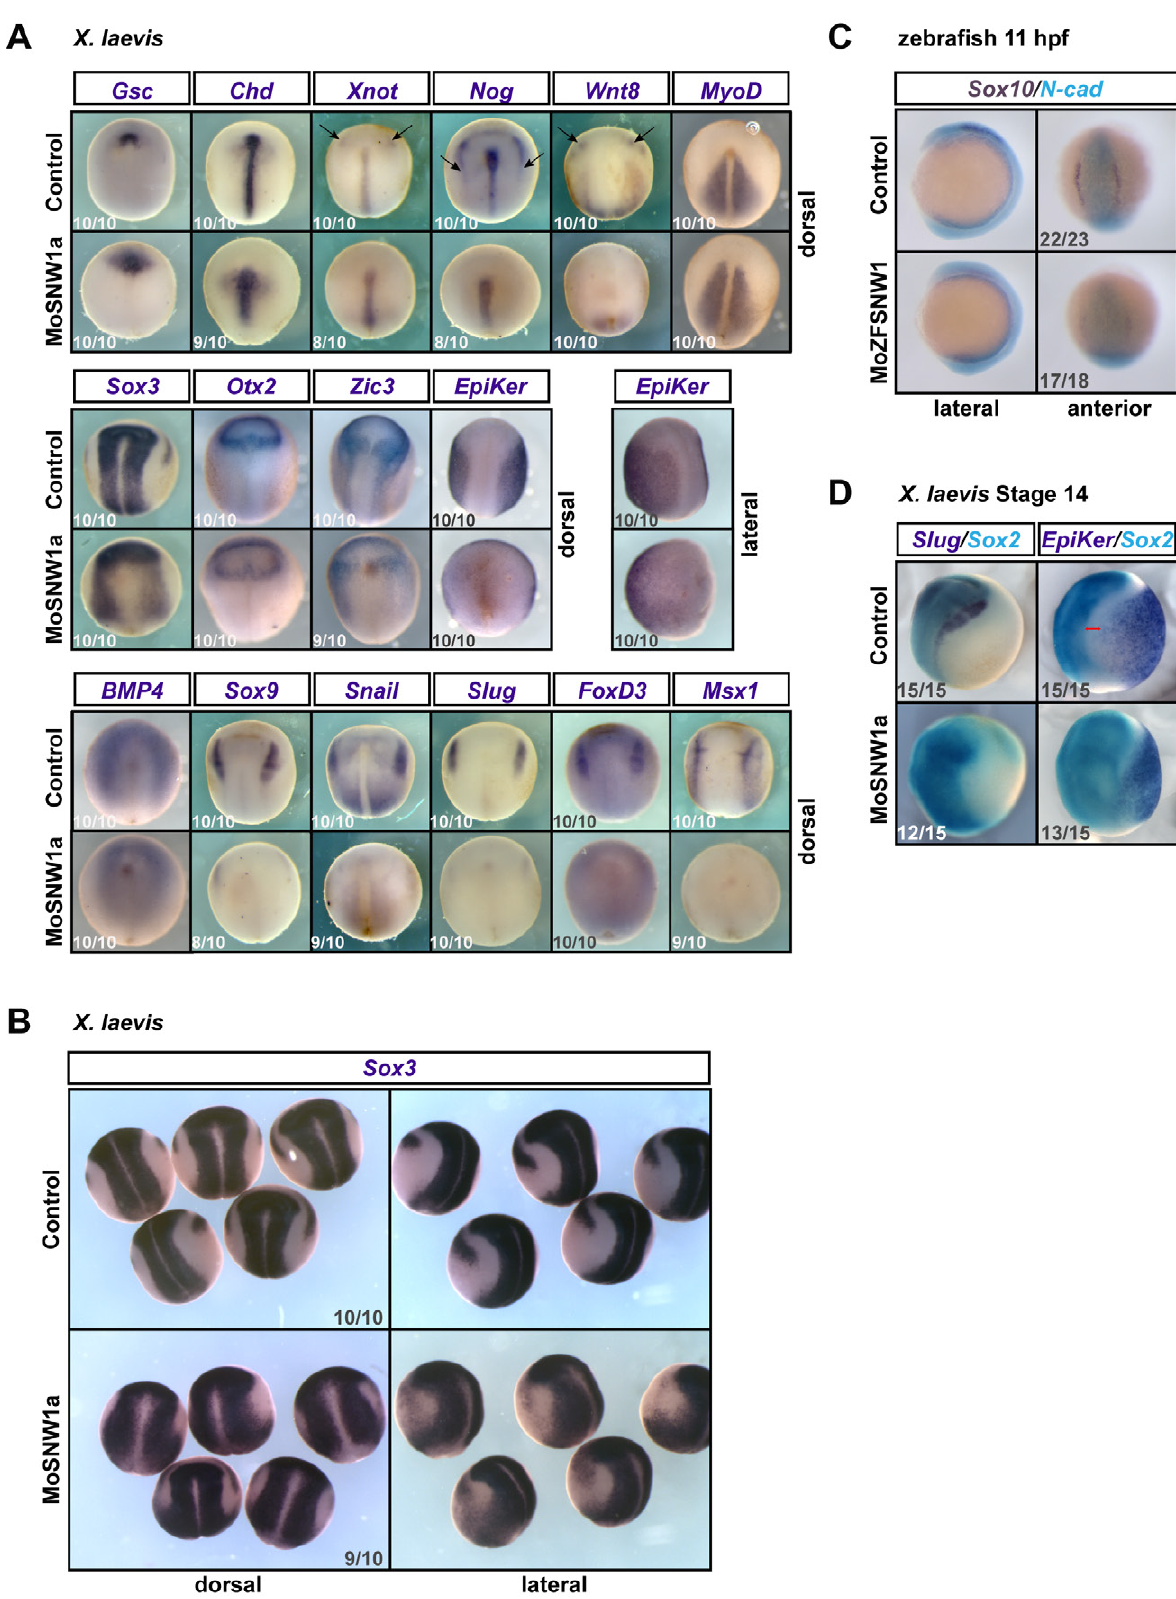
Figure 4. SNW1 is essential for specification of the border between neural and non-neural ectoderm. (A) Xenopus embryos were either uninjected (control) or injected with 20 ng of MoSNW1a at the one-cell stage. WISH was carried out for the dorsal mesoderm marker Goosecoid ( Gsc ), the dorsal midline markers Chordin ( Chd ), Xnot , and Noggin ( Nog ), the paraxial mesoderm markers Wnt8 and MyoD , the neural plate marker Sox3 , the